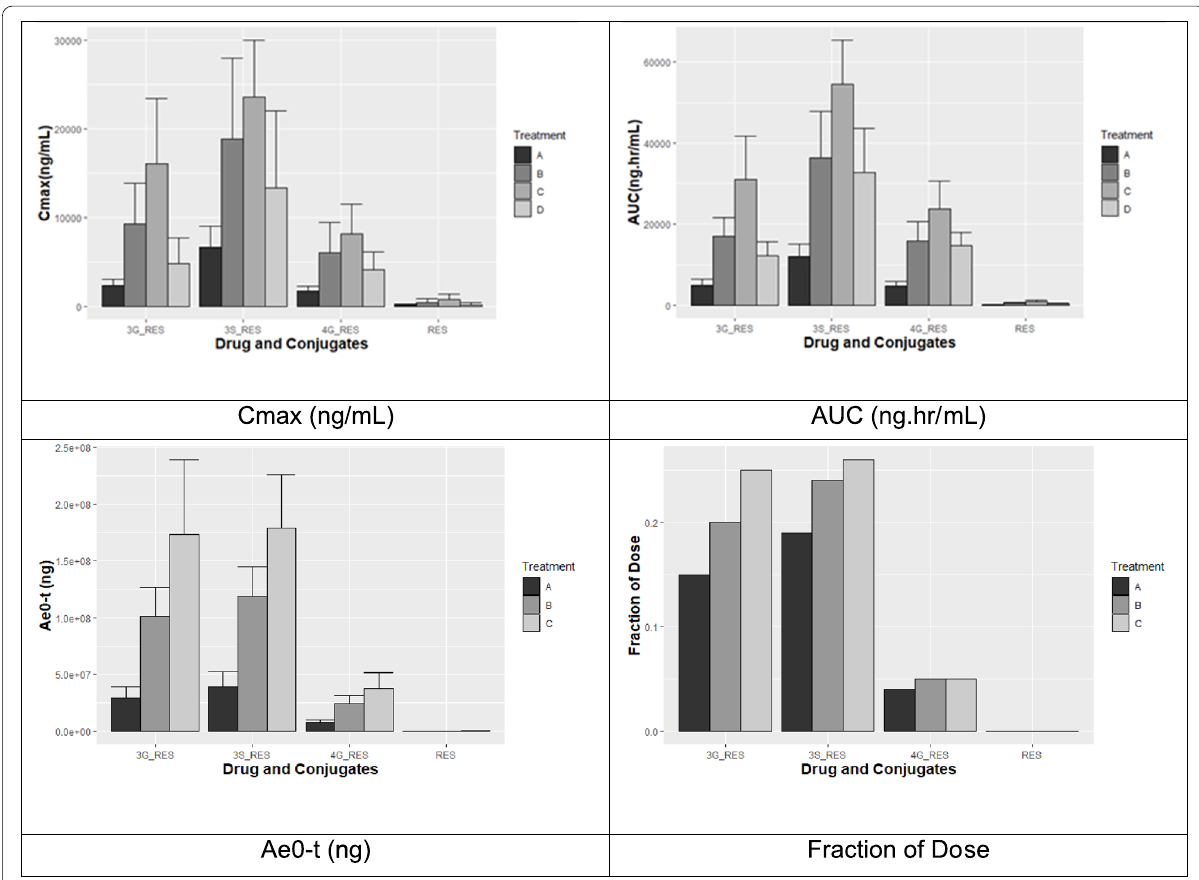
Fig. 3 Column plots of Cmax (ng/mL), AUC (ng.hr/mL), amount (Ae0‑t (ng) ) and fraction collected in urine of RES, 3_RES, 3S_RES, and